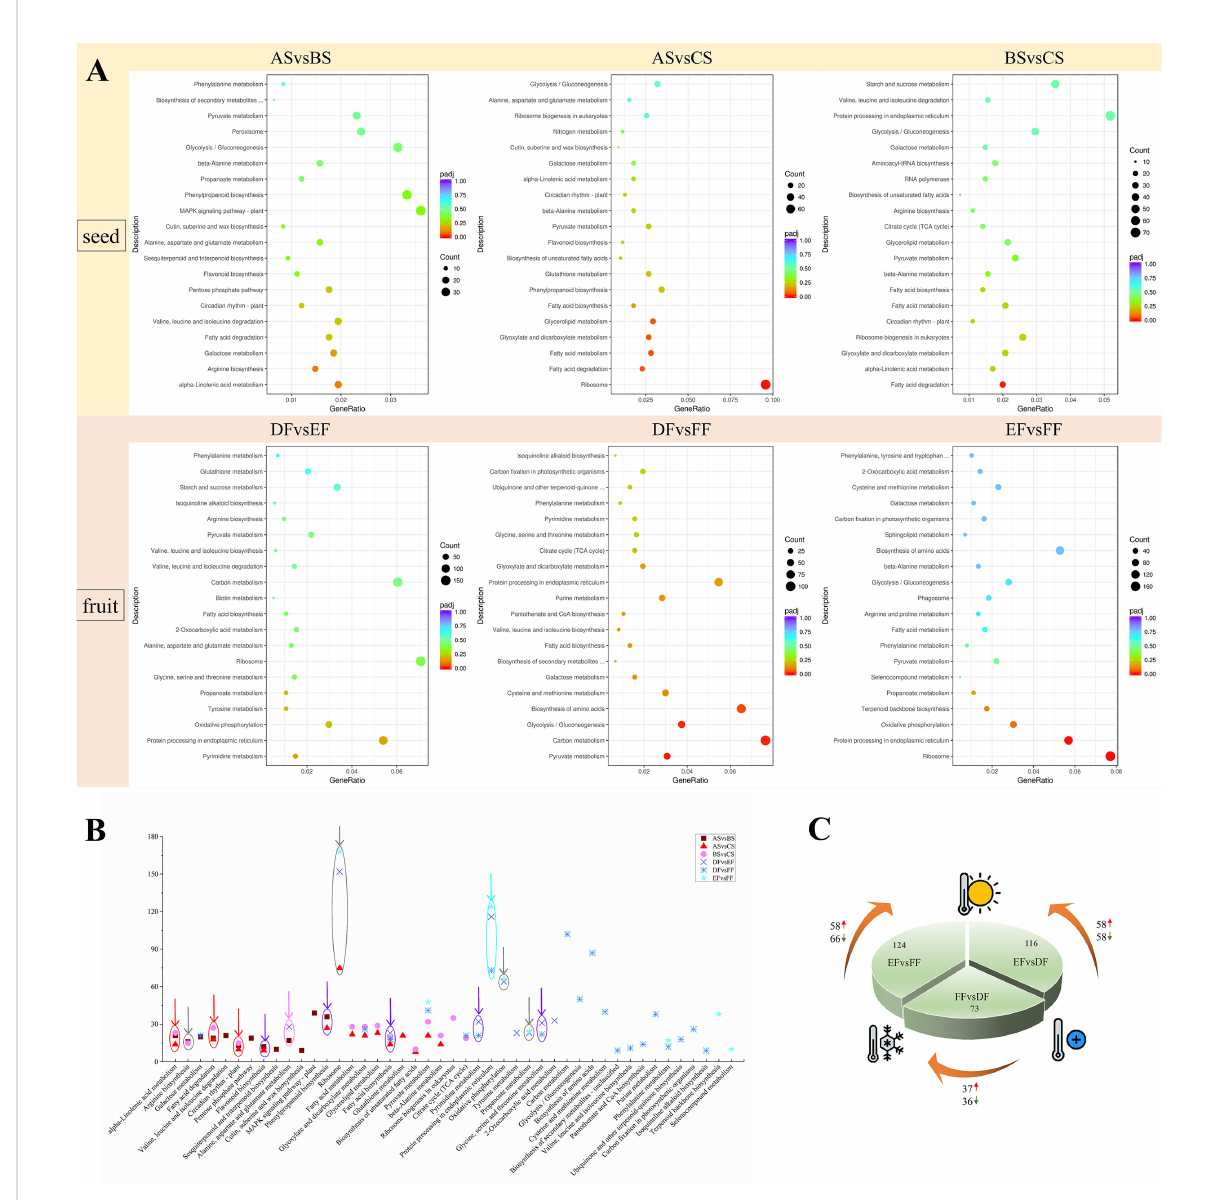
FIGURE 2 The Kyoto Encyclopedia of Genes and Genomes (KEGG) pathways analysis with signi fi cant enrichment of DEGs in seeds and fruits of strawberry. (A) KEGG pathways were enriched with up-regulated DEGs between different groups. GeneRatio represents the ratio of the number of differential genes annotated to the KEGG pathway to the total number of DEGs. Count represents the number of DEGs annotated to the KEGG pathway. padj represents the p-value corrected by multiple hypothesis testing. (B) Analysis of signi fi cant KEGG pathway enriched between different groups (ASvsBS, ASvsCS, BSvsCS, DFvsEF, DFvsFF, and EFvsFF). The red arrow represents the simultaneous enrichment in ASvsBS, ASvsCS, and BSvsCS, the gray arrow represents the simultaneous enrichment in RT vs Heat and Heat vs Cold (ASvsBS and BSvsCS; DFvsEF and EFvsFF), the purple arrow represents the simultaneous enrichment in RT vs Heat and RT vs Cold (ASvsBS and ASvsCS; DFvsEF and DFvsFF), the pink arrow represents the simultaneous enrichment in RT vs Heat (ASvsBS and DFvsEF), and the cyan arrow represents the simultaneous enrichment in DFvsEF, DFvsFF, and EFvsFF. (C) Analysis of the protein processing in endoplasmic reticulum pathway of fruits under different temperature